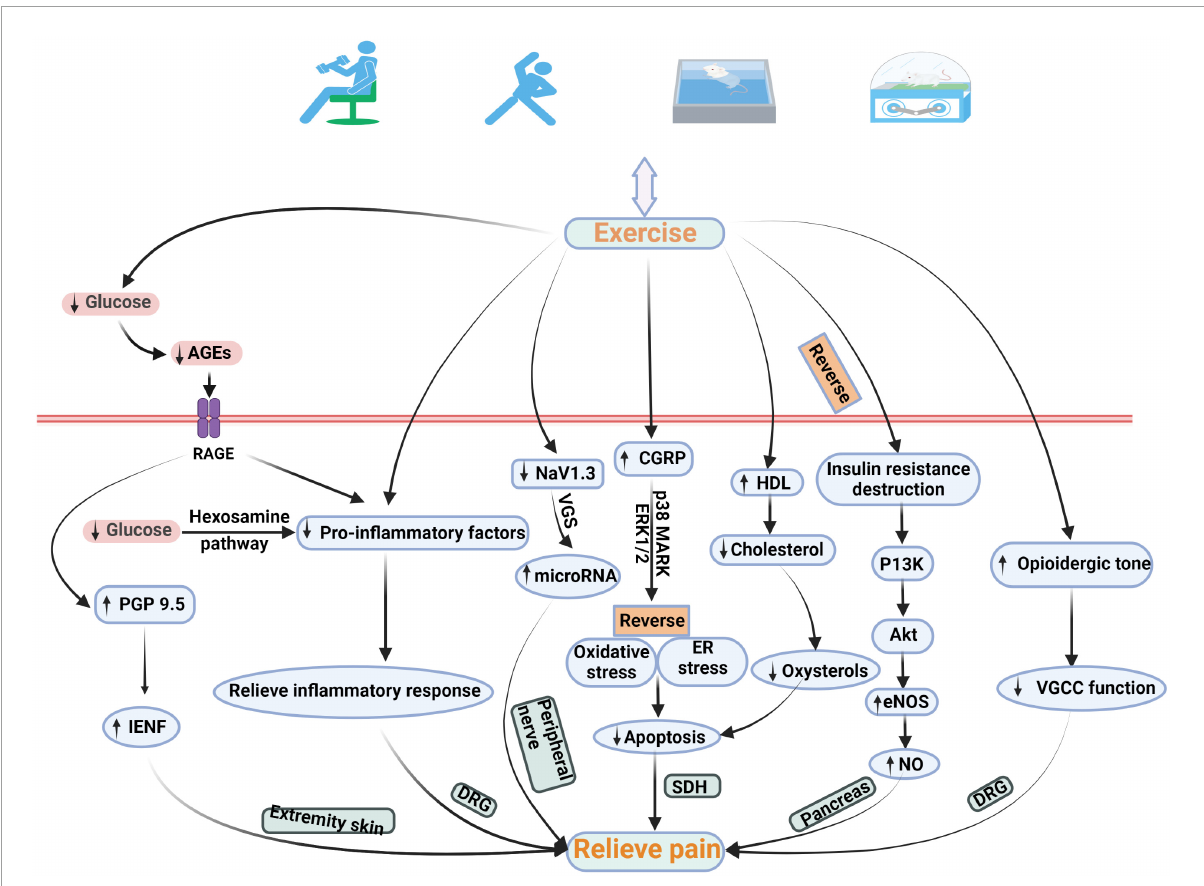
FIGURE1 Schematic diagram of the possible pathological mechanism of exercise in the treatment of DNP. Exercise relieves DNP by changing the quantity of IENFs, expression of pro-inflammatory factors, NaV1.3, CGRP, HDL, and eNOS, and VGCC function. AGEs, advanced glycation end products; IENF, intra-epidermal nerve fiber; CGRP, calcitonin gene-related peptide; ASK1, apoptosis signal-regulating kinase 1; p38 MARK, p38 mitogen-activated protein kinase; ERK 1/2, extracellular signal-regulated kinase 1 / 2 ; ER, endoplasmic reticulum; PI3K, phosphatidylinositol-3-kinase; eNOS, endothelial nitric oxide synthase; VGCC, voltage-gated calcium